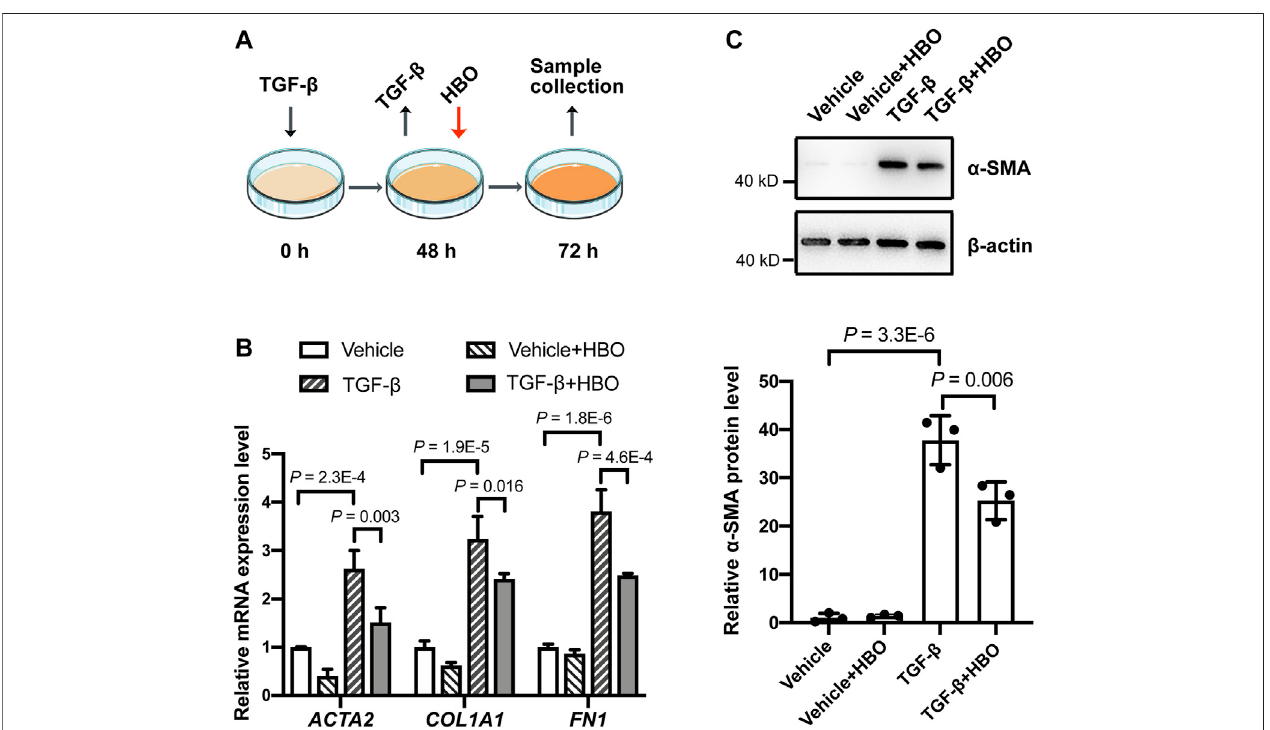
FIGURE 5 | Effects of HBO treatment on TGF- β – induced fi broblast activation in HFL1 cells. (A) Schematic diagram of the experimental procedure. In brief, TGF- β (5 ng/ml) was added to HFL1 cells for 48 h to induce fi broblast activation, after which TGF- β was removed, and cells were exposed to 2.5 ATA HBO for 90 min immediately.Sampleswerecollectedat72 hafterthebeginningofTGF- β treatment. (B) ThefoldchangeinthemRNAlevelsof ACTA2 ( α -SMA), COL1A1 (collagenI),and FN1 ( fi bronectin) in HFL1 cells with indicated treatments. ACTB ( β -actin)-normalized mRNA levels in control cells (vehicle) were used to set the baseline value at unity. (C) Protein expression of α -SMA in HFL1 cells with indicated treatments. β -actin was used as a loading control. In the graph, β -actin – normalized protein levels in control cells (vehicle) were used to set the baseline value at unity. Data in (B,C) are mean ± s.d., with p values indicated. n (cid:2) 3 samples each group. Data were analyzed with one-way